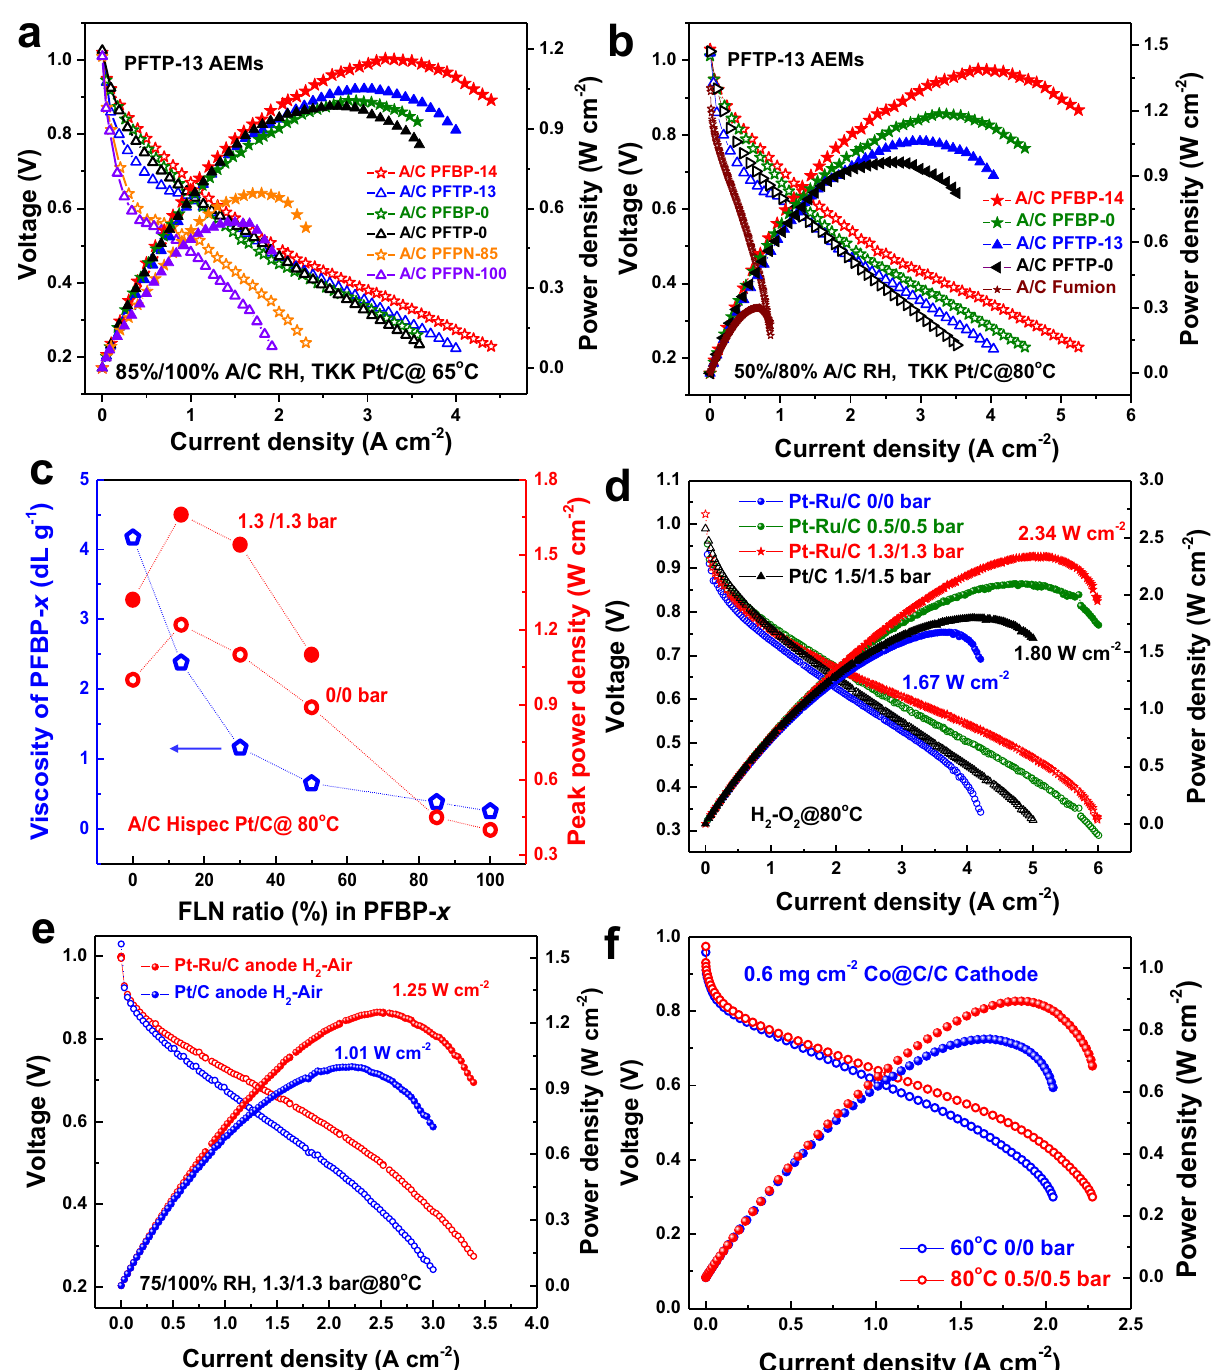
Fig. 4 Fuel cell performance. a The power density of AEMFCs with different AEIs and PFTP-13 AEMs (25 ± 3 μ m) based on A/C TKK Pt/C catalysts (0.33 mg cm − 2 ): 1000/1000 mL min − 1 H 2 – O 2 fl ow rate, 65 °C, 85%/100% A/C RH, and 0.5/0.5bar back pressure. b the power density of AEMFCs with different AEIs and PFTP-13 AEMs (25 ± 3 μ m) based on A/C TKK Pt/C catalysts (0.33 mg cm − 2 ): 80 °C, 50%/80% A/C RH, and 1.3/1.3 bar backpressure. c The relationship between the PPDs and the intrinsic viscosity of PFBP- x AEIs: PFTP-13 AEMs (25 ± 3 μ m), H 2 – O 2 , A/C Hispec Pt/C catalysts (0.33 mg cm − 2 ), 80 °C, the A/C fl ow rate of 1000/1000 mL min − 1 , 75%/100% A/C RH. Hollow circle symbols are PPDs without back pressure, while fi lled circle symbols are PPDs with 1.3/1.3 bar back pressure. d The power density of AEMFCs based on Pt – Ru/C anode with backpressure: PFBP-14 AEIs and PFTP-13 AEMs (20 ± 3 μ m), 80 °C, 75%/100% A/C RH, 1000/1000 mL min − 1 H 2 – O 2 fl ow rate, different back pressures, Pt – Ru/C anode (0.42 mg cm − 2 ), Hispec Pt/C cathode (0.33 mg cm − 2 ). A/C Hispec Pt/C (0.33 mg cm − 2 ) for comparison. e the power density of AEMFCs in H 2 – air (CO 2 free) with different anode catalysts: PFBP-14 AEIs and PFTP-13 AEMs (20 ± 3 μ m), 80 °C, 75%/100% A/C RH, 1000/2000 mL min − 1 fl ow rate, 1.3/1.3 bar A/C backpressure, 0.33 mg cm − 2 A/C catalyst loading. f PFAP-based AEMFCs with 0.6 mg cm − 2 loading of Co@C/C cathode and Pt – Ru/C anode with 1000/1000 mL min − 1 H 2 – O 2 fl ow rate at 60 and 80 °C. PPDs reached 0.769cm − 2 and 0.891 W cm − 2 at 60 °C without backpressure and at 80 °C with 0.5/0.5 bar backpressure,